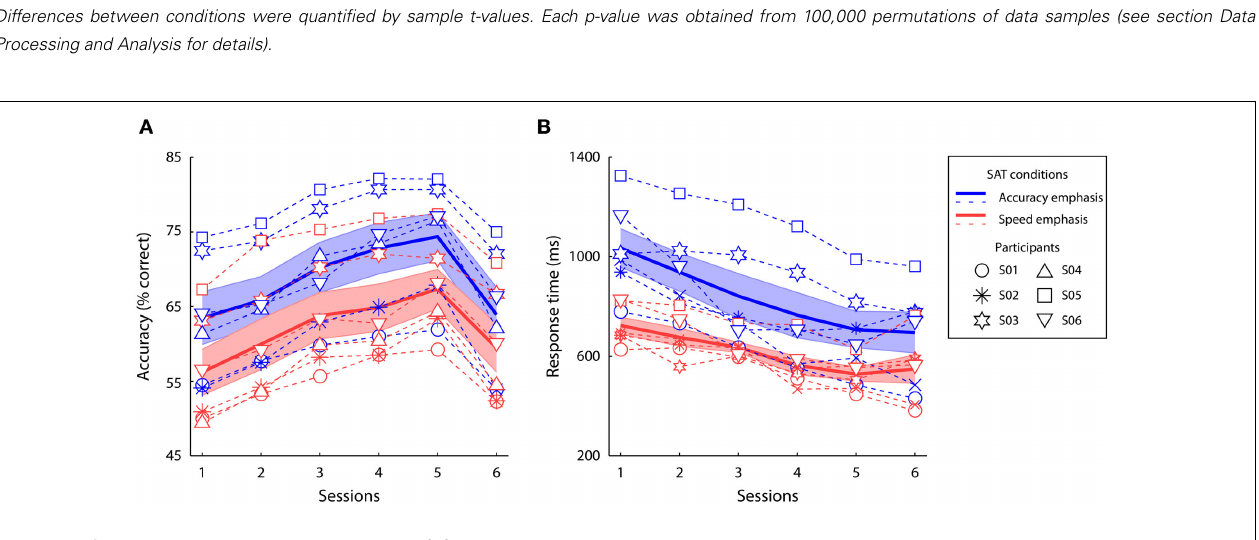
FIGURE 3 | Behavioral results. Decision accuracy (A) and mean response time (B) of the speed emphasis and accuracy emphasis conditions at each training session. The solid lines and the shaded